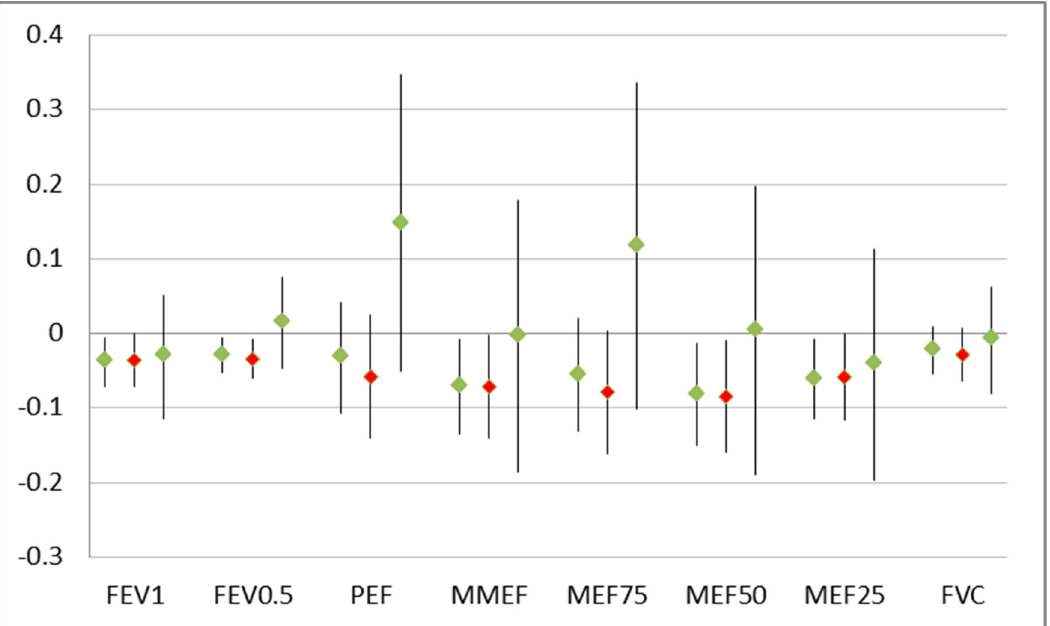
Figure 1. Results of linear regression on number of smokers on lung function parameters: Change in liter (FVC, FEV1, FEF0.5) or in liter/sec (other parameters) per smoker. Point estimates and 95% confidence interval: All 433 children ( left ), 53 children without breast-feeding (red marker, middle ), and 380 breast-fed children ( right ).